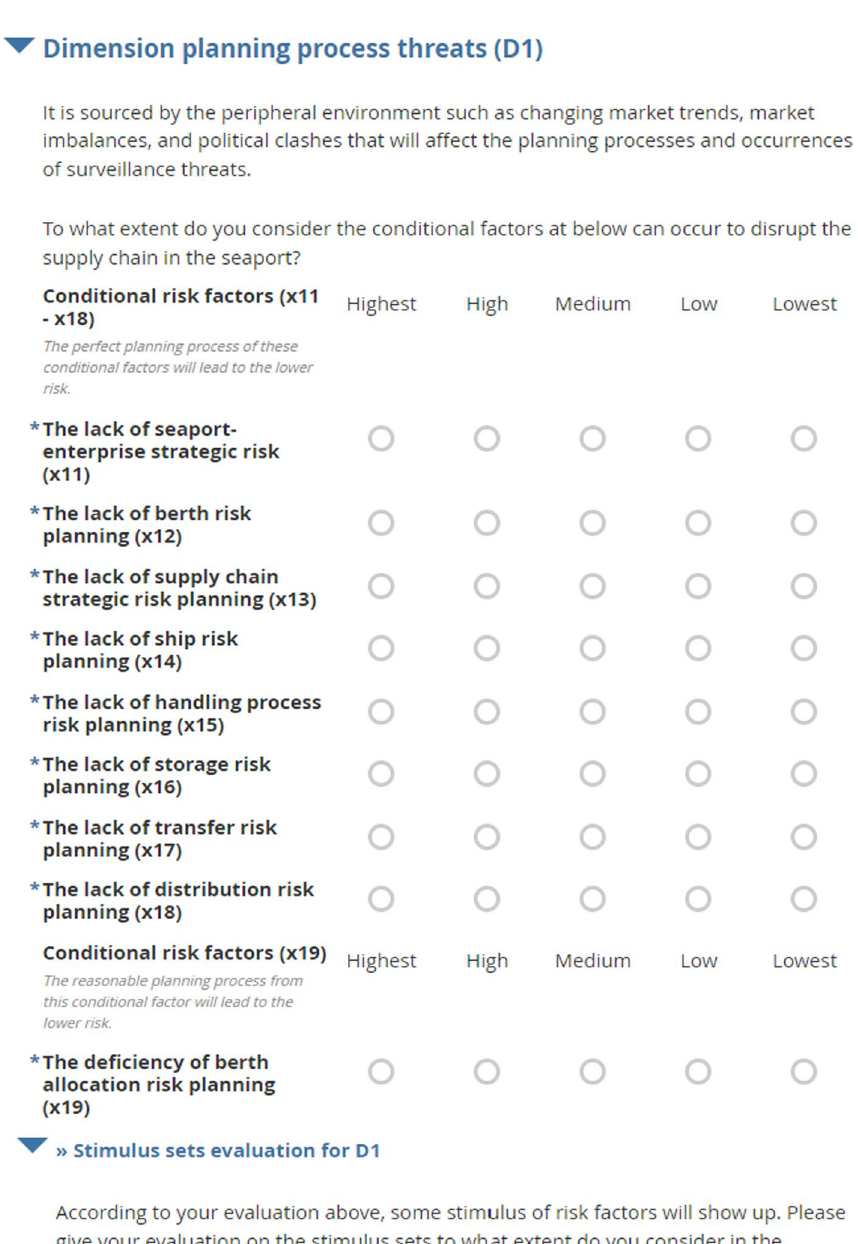
Fig. 7 A section of the